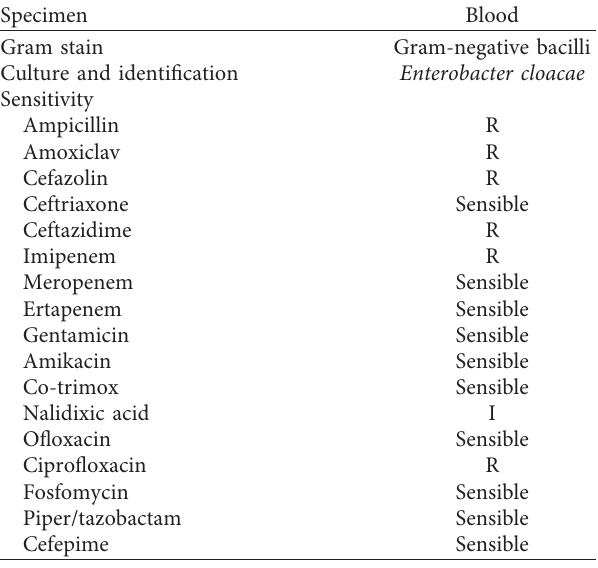
Table 2: Antibiogram of Enterobacter cloacae . Specimen